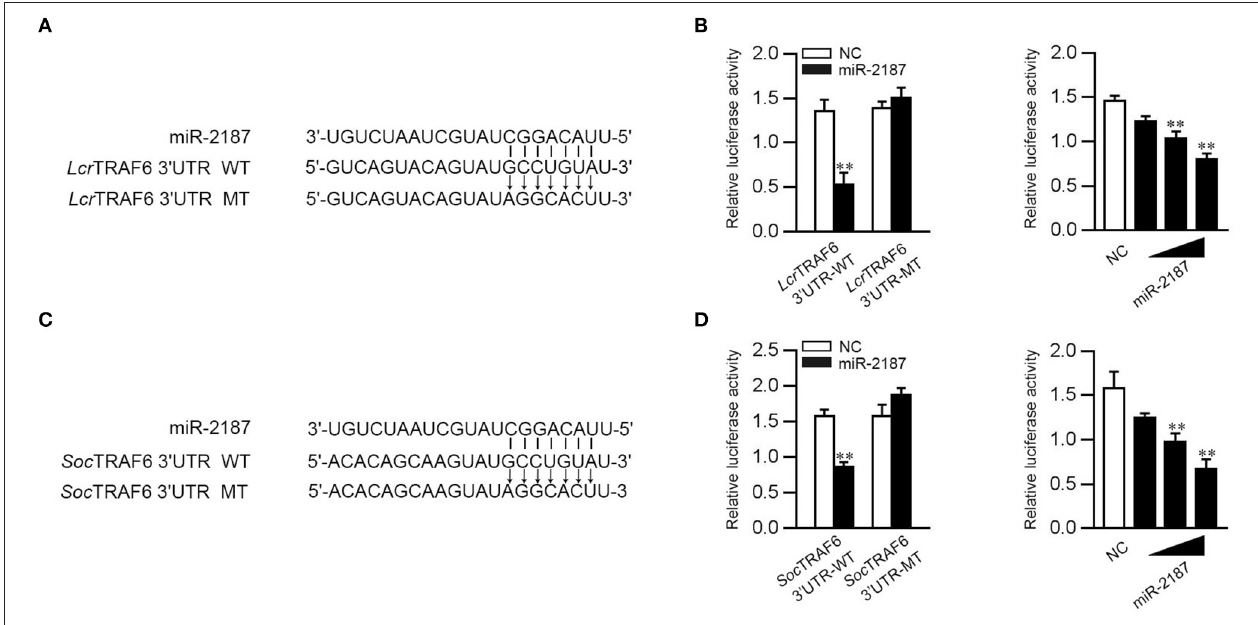
FIGURE 8 | miR-2187 regulation of TRAF6 is widely found in teleost fish. (A) Schematic diagram of the predicted target sites of miR-2187 in the 3 ′ UTR of L. crocea TRAF6. (B) EPC cells were transfected with NC or miR-2187, along with the wild-type or mutant L. crocea TRAF6 3 ′ UTR and the luciferase activity was determined (left). The dose gradient experiments were conducted for miR-2187 transfection (right). (C) Schematic diagram of the predicted target sites of miR-2187 in 3 ′ -UTR of S. ocellatus TRAF6. (D) EPC cells were transfected with NC or miR-2187, along with the wild type or the mutant type of S. ocellatus TRAF6 3 ′ -UTR and the luciferase activity was determined (left). The dose gradient experiments were conducted for miR-2187 transfection (right). All data are presented as the means ± SE from at least three independent triplicated experiments. ** p < 0.01 vs. the